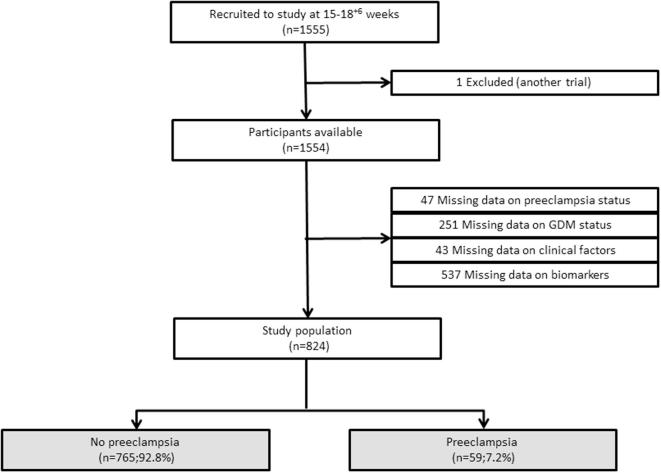
Study population.